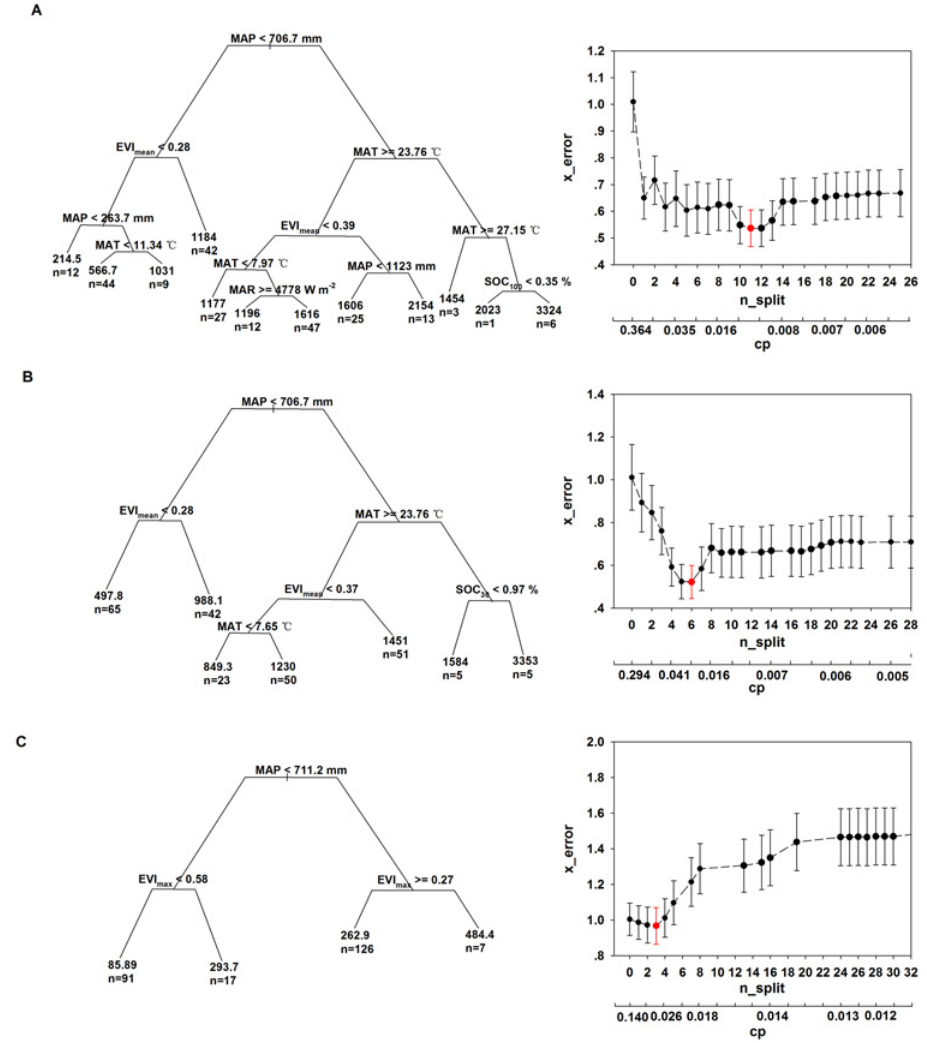
Fig 3. Classification and Regression Trees analysis of the controlling factors for AGPP(A), ARE(B), ANEP(C). Left part: Classification and regression trees for AGPP(A), ARE(B), ANEP(C); Right part: The n_split, x_error and cp value used in tree building for AGPP(A), ARE(B), ANEP(C).